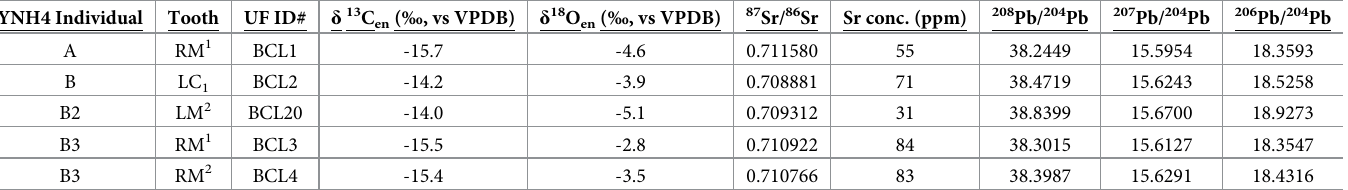
Table 4. YNH4 tooth enamel isotopic